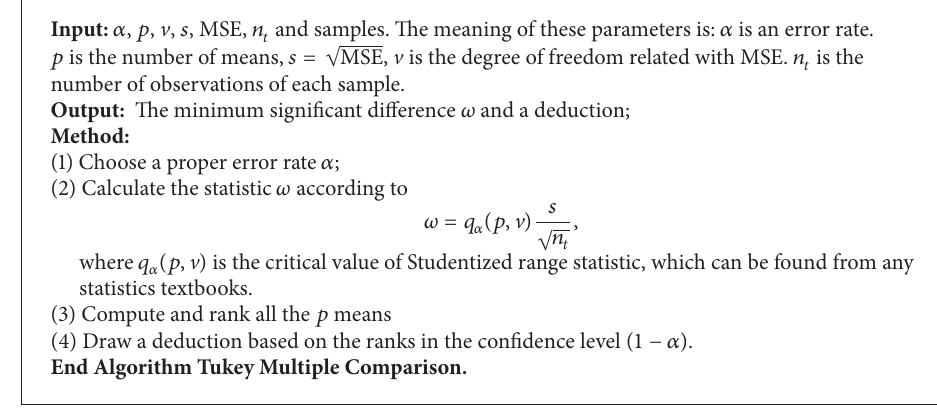
Algorithm 3: Tukey’s multiple comparison: equal sample size. Table 4: Comparison of AUC between six classifiers. The ranks in the parentheses are used in computation of the Friedman test.